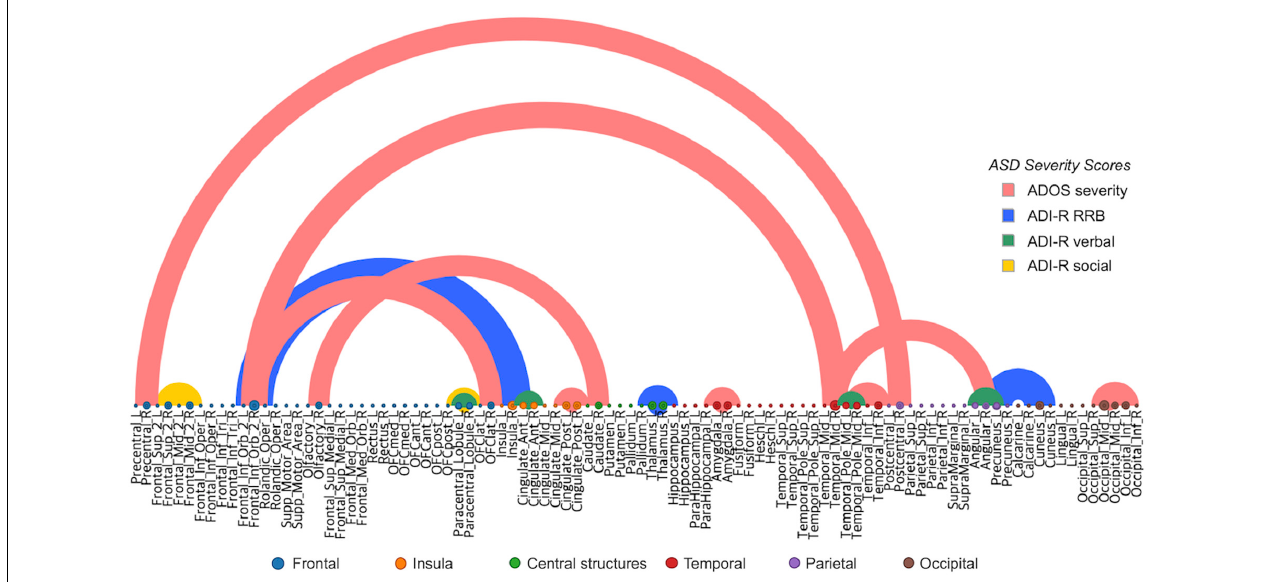
FIGURE 5 | Most predictive connections for ASD severity score (Red), ADI RRB (Blue), ADI verbal (Green), and ADI social (Yellow), learned by our proposed model. For each severity score, the connections that have the top 10% magnitude were shown for clarity. Thickness of the line represents the magnitude of partial